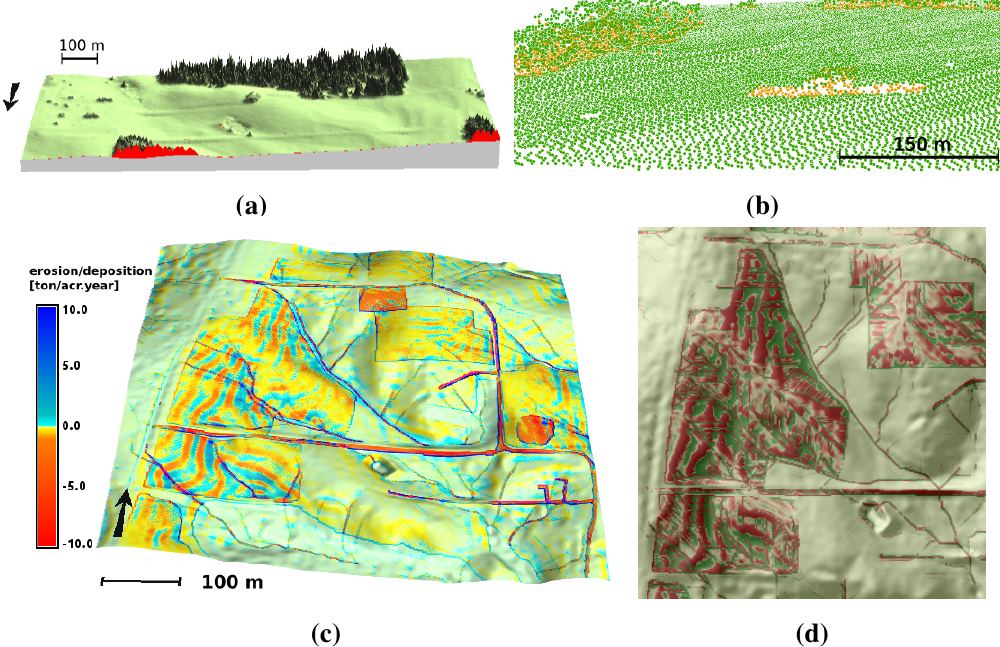
Figure 3. Images from the Geospatial Modeling and Analysis course assignment reports. Working with LiDAR data: ( a ) bare ground and first return surface cross-section in GRASS GIS; ( b ) multiple return point cloud visualized in ArcGIS. Modeling landscape processes: ( c ) erosion-deposition map draped over an elevation model visualized in GRASS GIS; ( d ) erosion-deposition map displayed over shaded relief in ArcGIS.